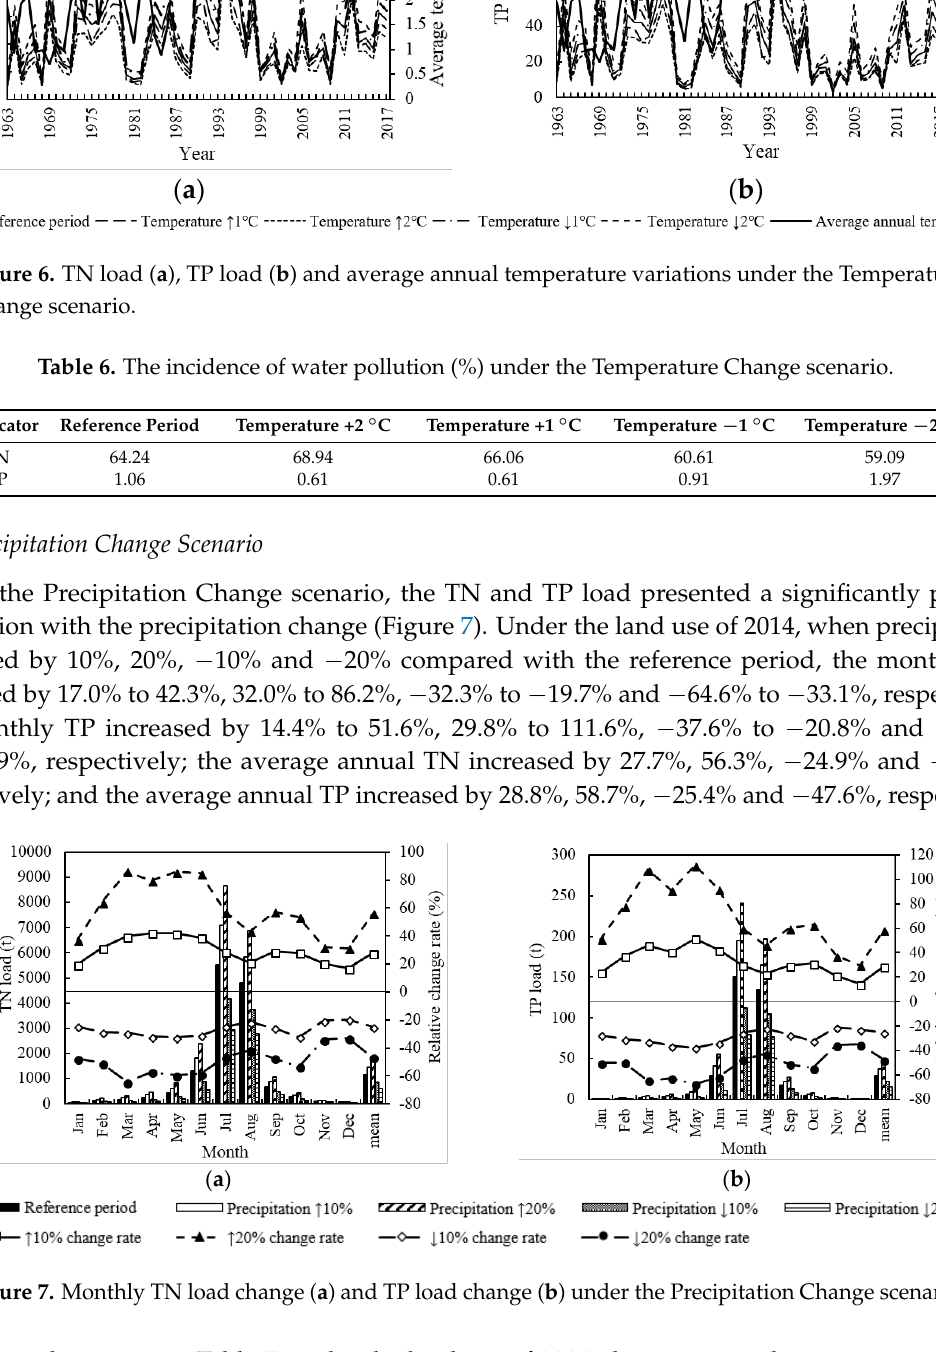
Table 7. The extreme values of TN and TP load under the Precipitation Change scenario. TN Extreme Value (%) Benchmark (t)